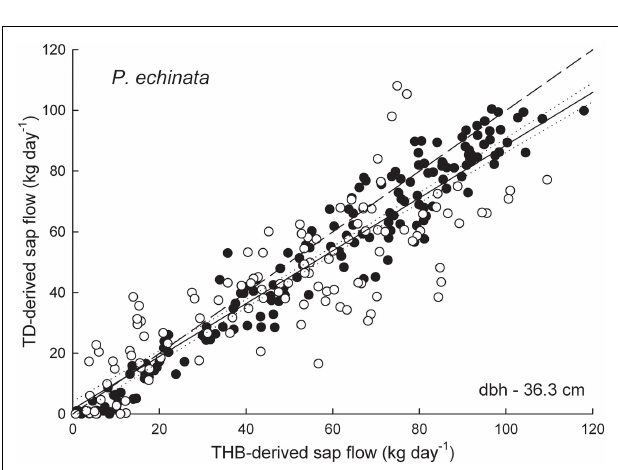
FIGURE 3 | Sap flow rates (kgday − 1 ) derived from the tissue heat balance (THB) system and thermal dissipation (TD) system using 2-cm long sensors in a 36.3-cm dbh Pinus echinata . TD flow rates were corrected for radial variation by comparing data between 0–2 and 2–4-cm depth sensors.The closed circles denote data from 2009 and the open circles denote data from 2010.The dashed line is the one to one line, the dotted lines are 95% confidence intervals around the best fit solid line ( y = 0.87 x + 1.57, r 2 =